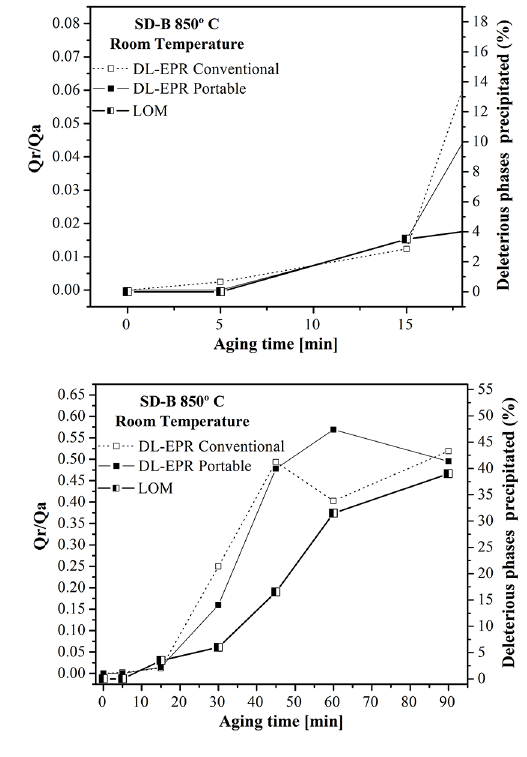
Figure 13. Qr/Qa ratios and deleterious phases precipitated percentage against aging time in SD-B samples aged at 850ºC till